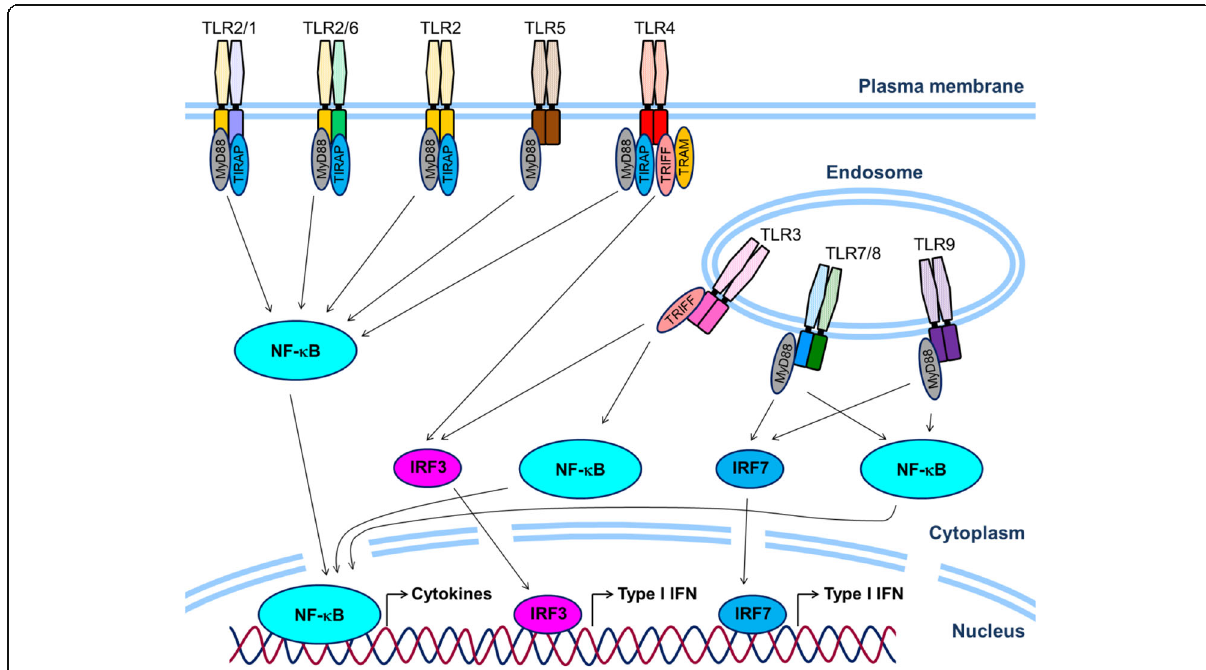
Fig. 1 Overview of TLR signaling. TLRs are classified into cell surface TLRs and intracellular TLRs. Each TLR recognizes their specific ligands and promotes gene expression of inflammatory molecules mainly via NF- κ B and IRF pathway in immune